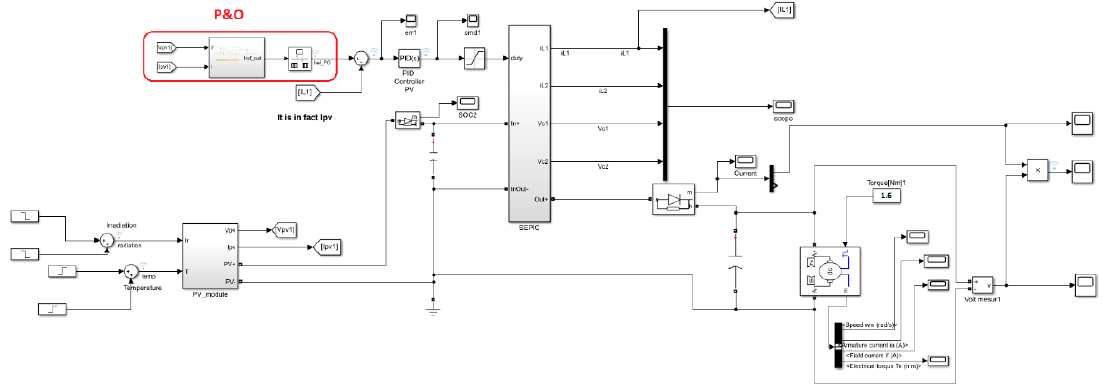
Figure 17. System architecture including the P&O algorithm.